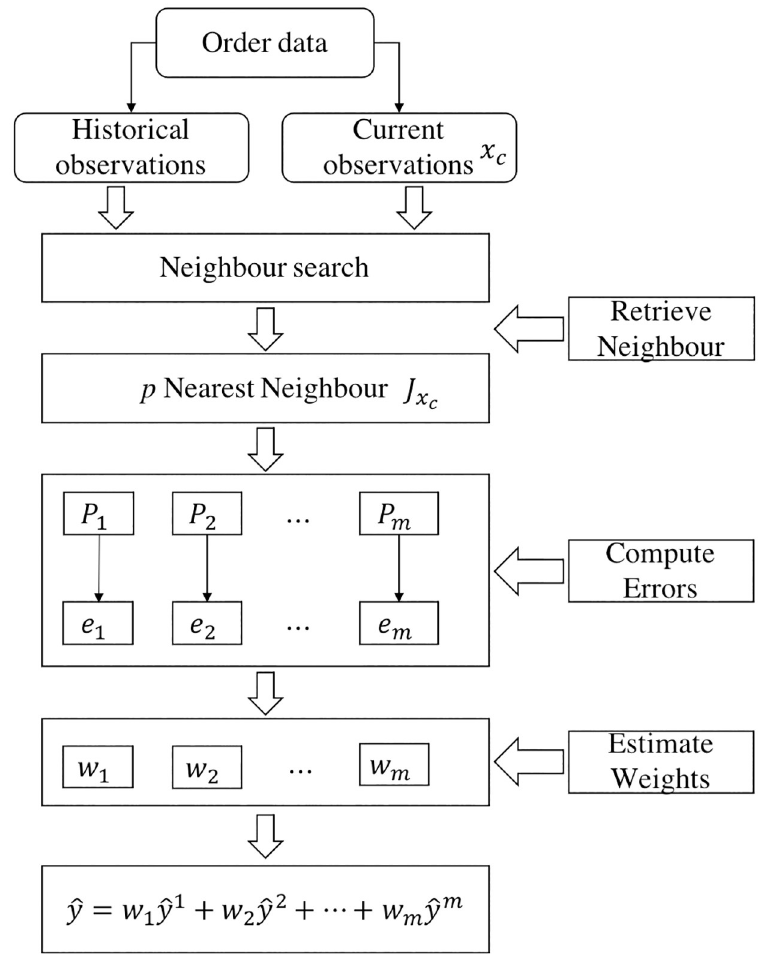
Fig 2. Flowchart based on the kNN fusion-based